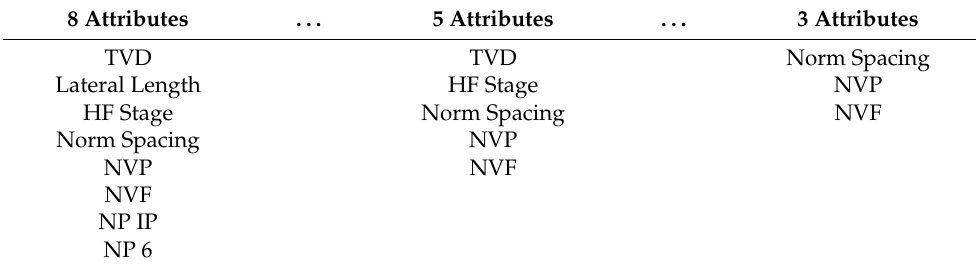
Table 7. Case study for input attributes.